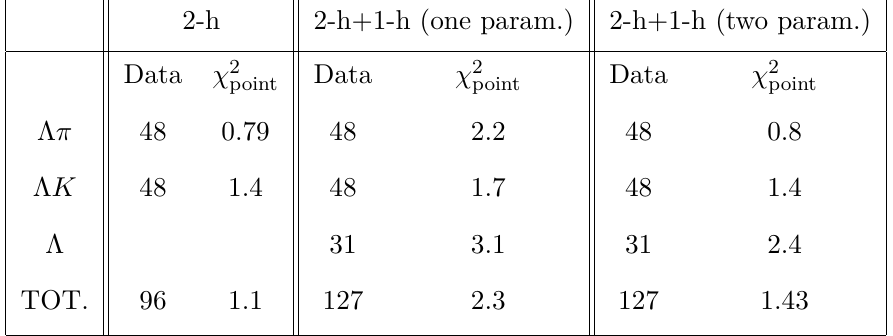
Figure 11 . Results within the Power-Law model fit for the two M ⊥ 2-h (blue solid line) and 1-h (orange dash-dotted line)